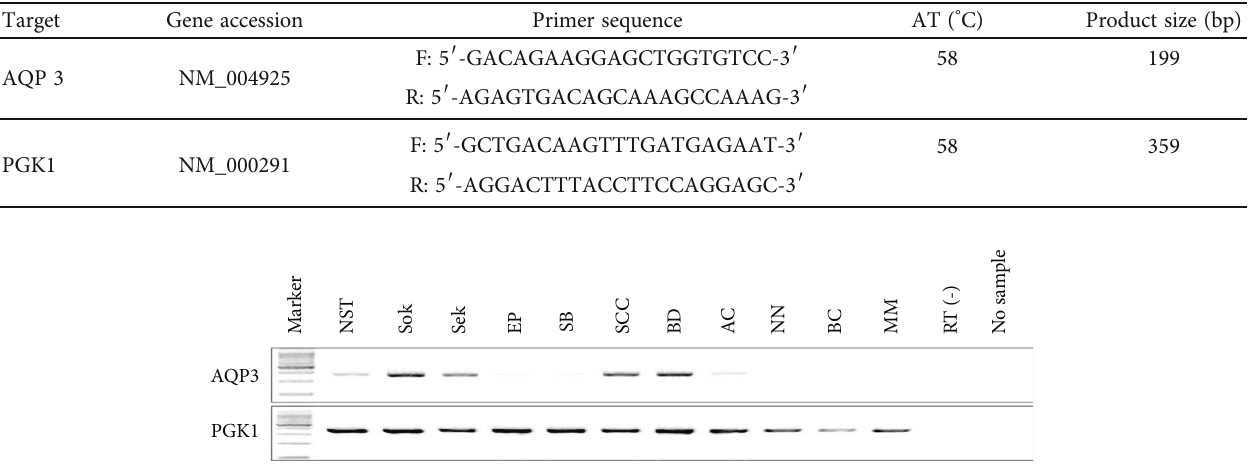
Table 2: Primer pairs used in RT-PCR.